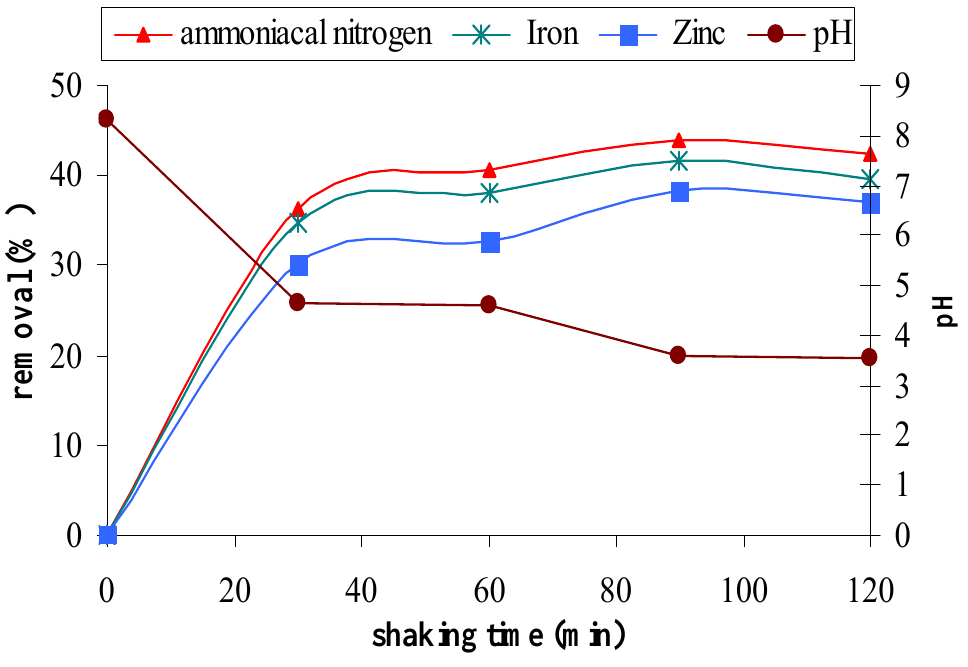
Figure 1. Influence of shaking time on ammoniacal nitrogen, iron and zinc removal efficiency (dosage = 40 g; shaking speed = 350 rpm; settling time = 120 min).